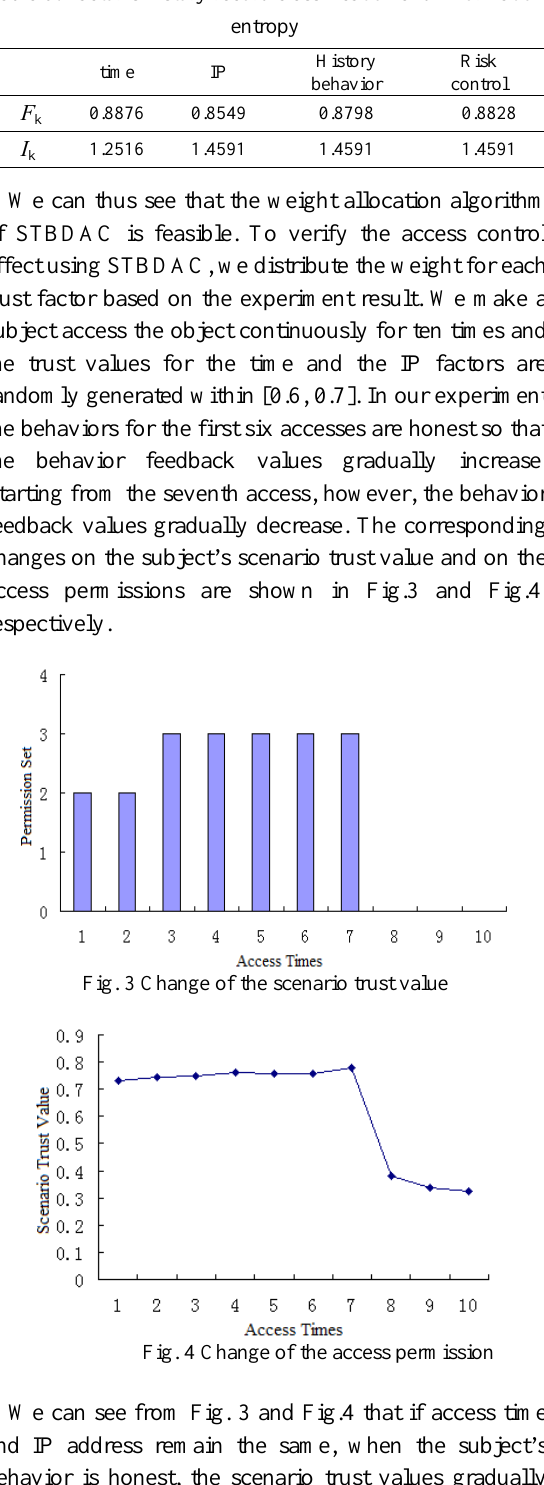
Fig. 4 Change of the access